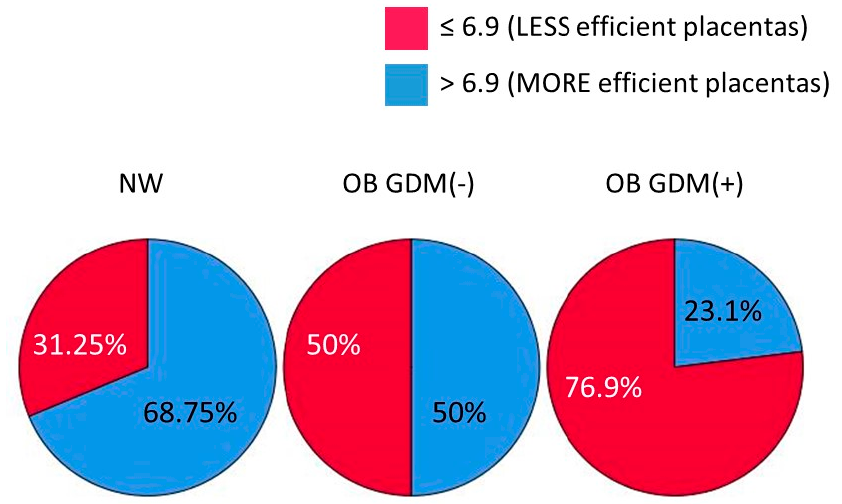
Figure 1. Distribution of placentas according to their efficiency for the three study groups (cut-off = 6.9, median value of placental efficiency). Data shown as a pie chart graph. Chi-square test: p = 0.049.